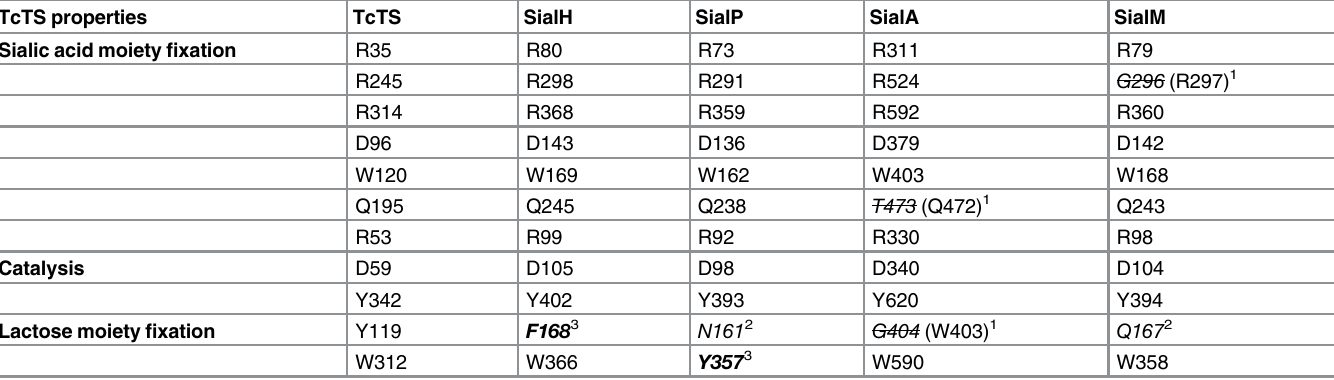
Table 3. Summary of the 3D alignment visualized in Fig